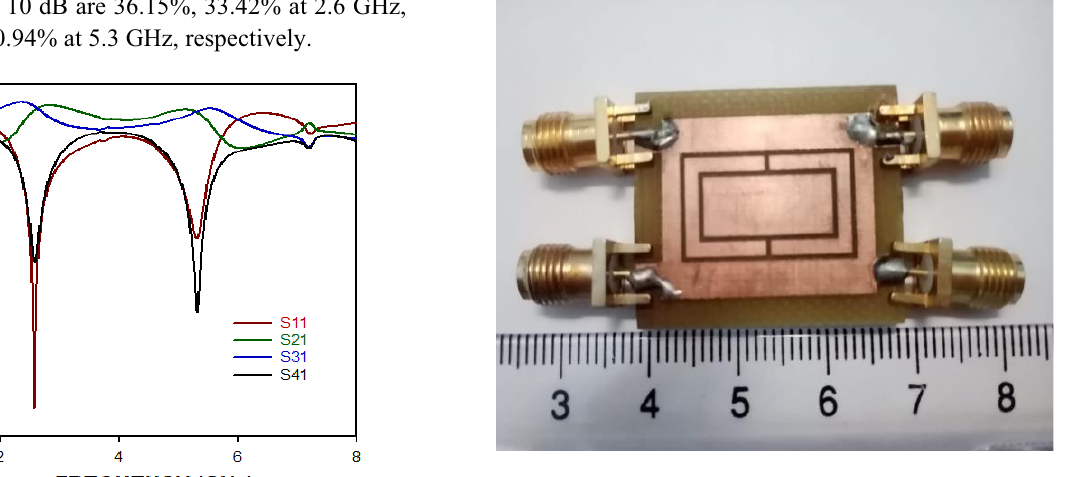
Fig.6. Proposed dual-band patch coupler frequency response